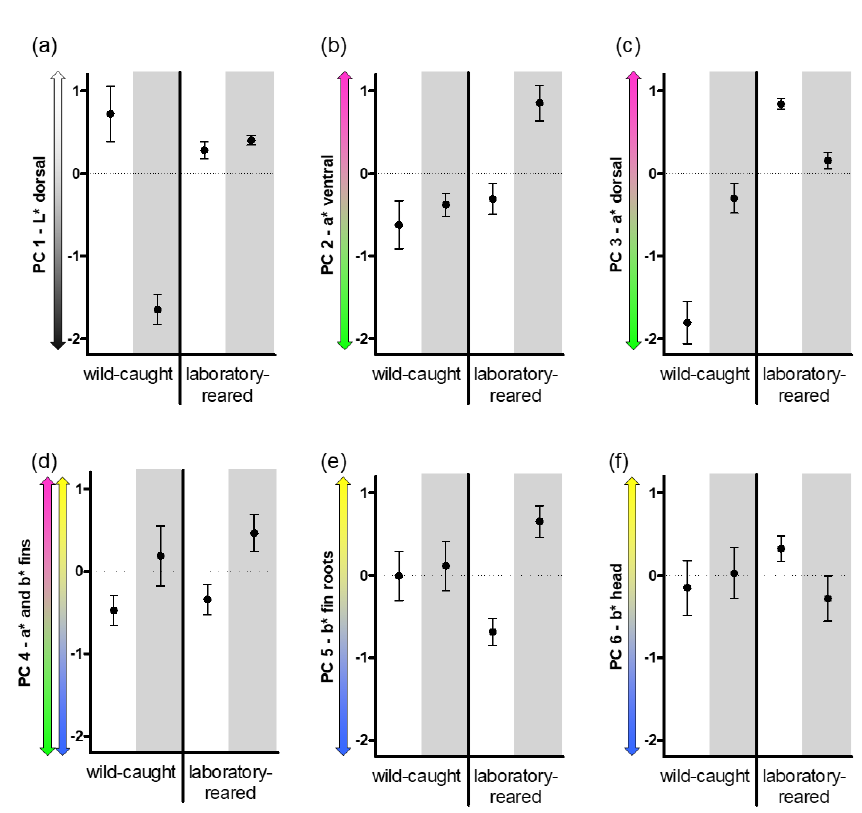
Figure A4. PC scores ± SE used to assess the broad-sense heritability of population differences in male body coloration by comparing wild-caught and laboratory-reared fish from the Tacotalpa drainage. The results are grouped by body region (dorsal area ( a , c ), ventral area ( b ), fins ( d , e ), and head ( f )) and the color ( L *, a * and b *) captured by the respective PC. The white background signifies fish from non-sulfidic habitats (Tac), while the gray background indicates H 2 S-adapted fish